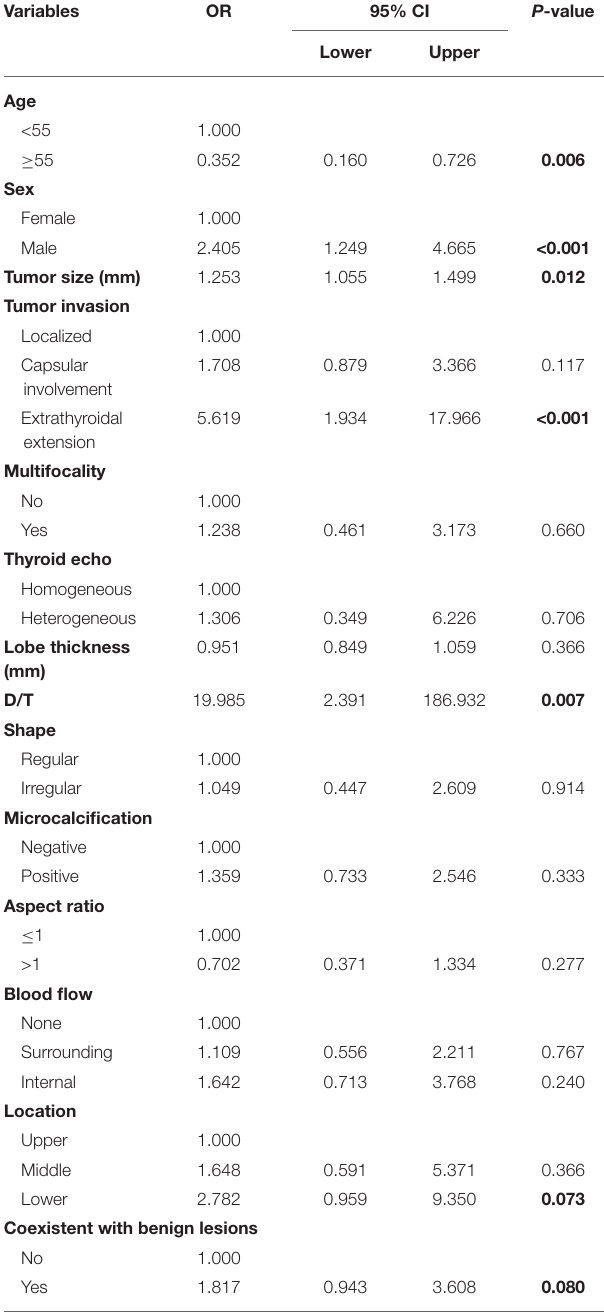
TABLE 1 | Univariate logistic regression of predicting cervical lymph node metastasis in papillary thyroid microcarcinoma (PTMC) patients.